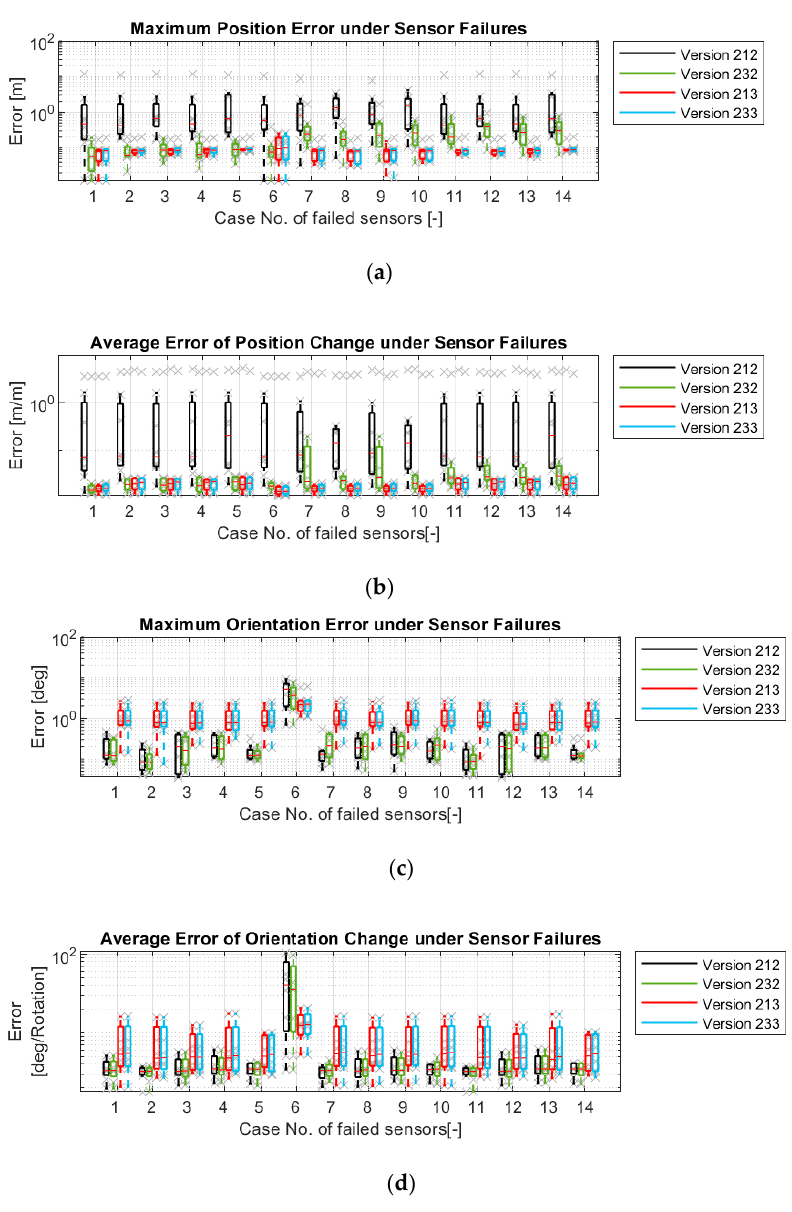
Figure 22. Simulation results of four odometry versions under sensor failures: ( a ) Maximum position errors; ( b ) Maximum orientation errors; ( c ) Average position errors; ( d ) Average orientation errors.